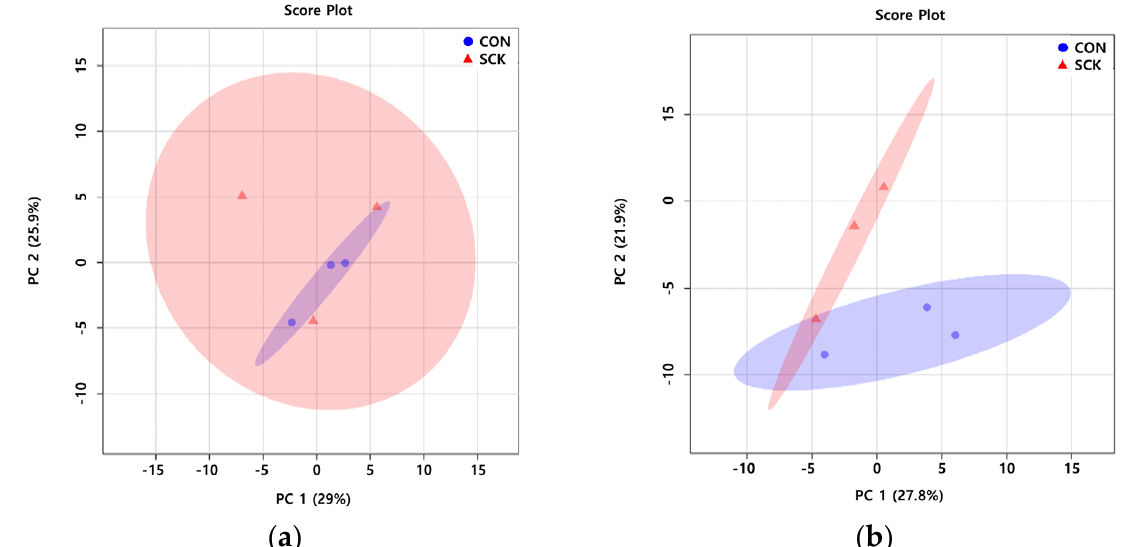
Figure 1. Principal components analysis (PCA) score plot based on rumen fluid ( a ) and milk ( b ) metabolites data in healthy (CON) and subclinical ketosis (SCK) groups by proton nuclear magnetic resonance analysis ( n = 3). On the score plot, each point represents an individual sample, with the blue circle representing the CON, and the red triangle representing the SCK group. The abscissa and represent the variance associated with PC 1 and 2, respectively.